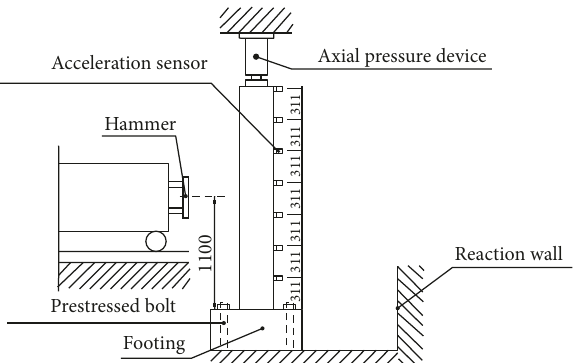
Figure 8: Arrangements of the restraint device and acceleration sensors.